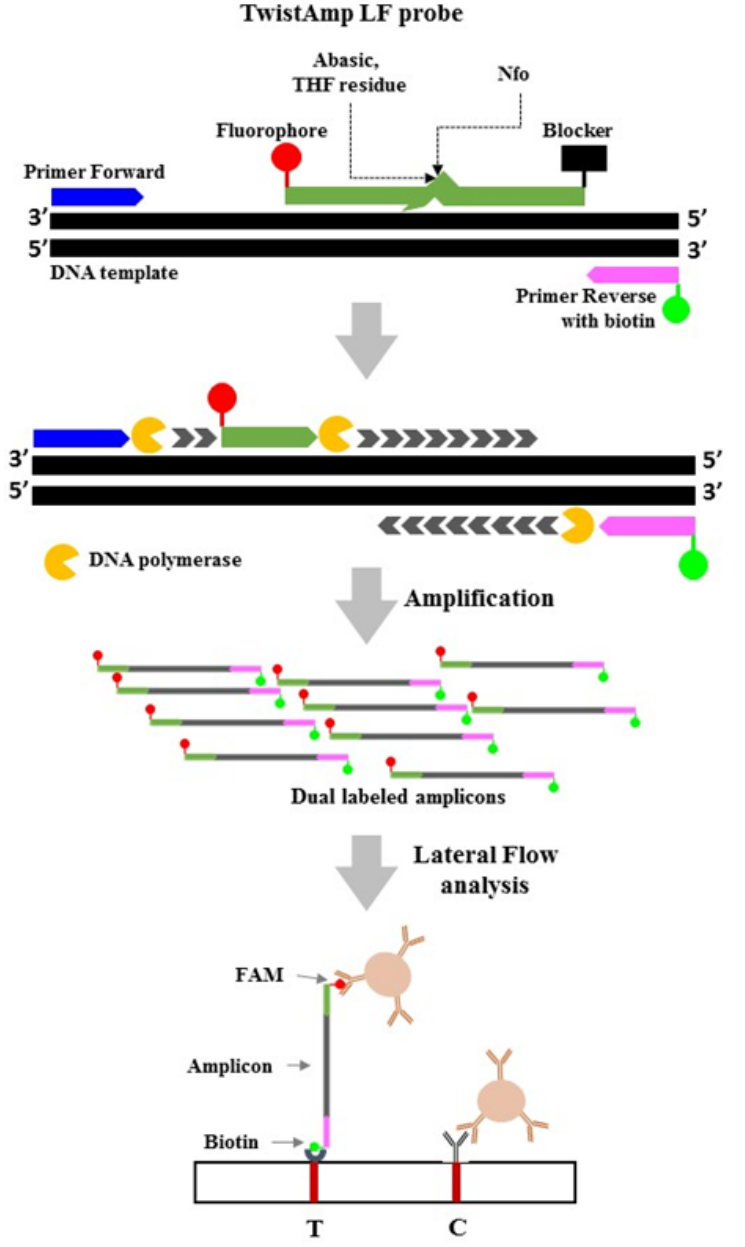
Figure 1. RPA-LFD reaction mechanism. The RPA followed a TwistAmp ® nfo kit. Amplification, with forward primer, labeled reverse primers and probe, occurred when endonuclease IV (nfo) recognizes and cleaves the tetrahydrofuran (THF) residue within the probe, detaching the 3′ -end block. A double labeled amplicon was formed. The RPA amplicons travel in a buffer stream, which contains antibody-coated gold particles, to be trapped at the test line by biotin–ligands, resulting in an appearance of dark-purple color indicative of a positive result. Non-captured gold particles move through the test line to be fixed at the control line by anti-rabbit antibodies.